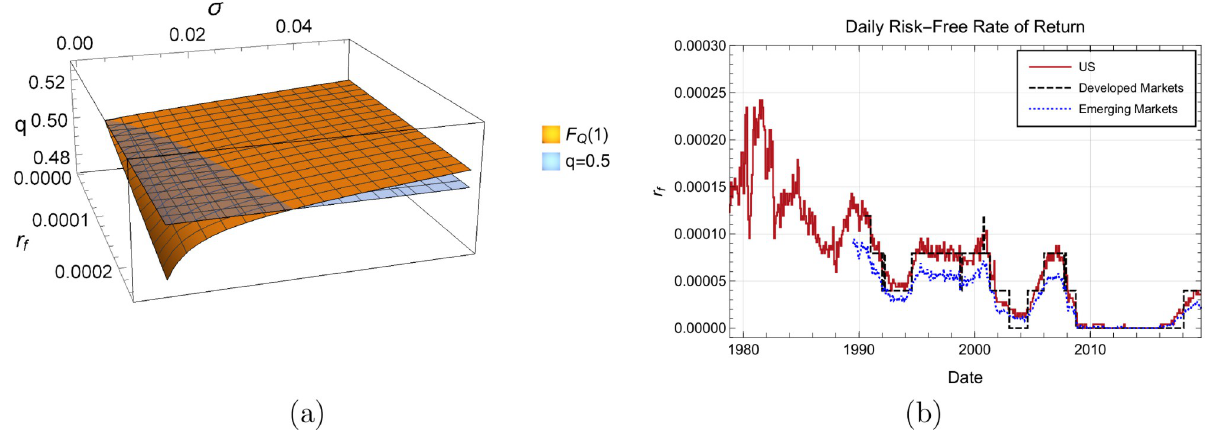
Fig 2. For a typical time series of Q i the parameter μ is close to zero oscillating on a small interval ranging from − 0.004 to 0.05. The risk-free rate oscillates between the interval [0, 0.061). For these values the probability of a negative return is q = 0.5 ± 0.02. Subfig 2(a) is the probability of of return r F negative return given the risk-free interest rate r f and mean σ . The σ parameter can be estimated from the return time series Q i , and r f is estimated from a reference asset that depends on the market being studied. Intersection with q = 0.5 is also shown. Subfig 2(b) is the daily risk-free rate of returns r the US market, developed markets and emerging markets. For the period ranging from 1978 to 2020 the daily risk-free rate oscillates in the interval [0, 0.061). Data was downloaded from